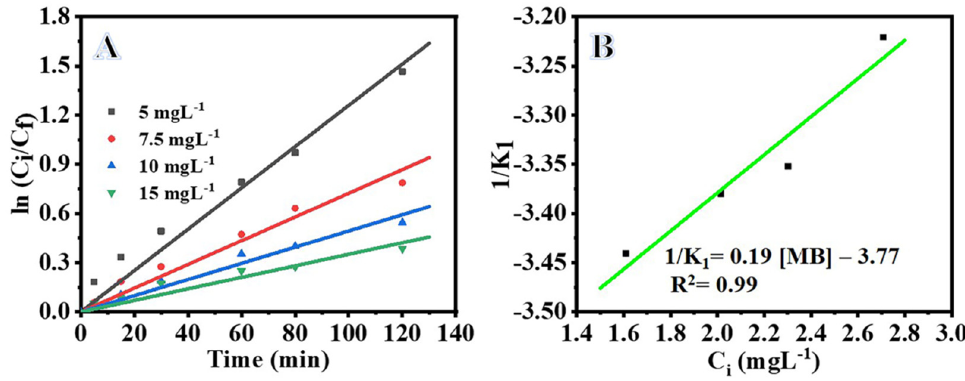
Figure 5. Influence of [MB] on photodegradation of MB, ( A ) ln Ci/Cf vs. time ( B ) modified LH plot for MB photodegradation. The parameters are: photocatalyst amount = 0.2 gm L − 1 , C i = 0.1 M, T = 298 K, and I = 25 W m − 2 . Table 1. Rate constants of reactions of MB photodegradation at various MB concentrations, reaction temperatures, light intensities, and NiTiO 3 /TiO 2 -decorated CNFs catalyst doses.